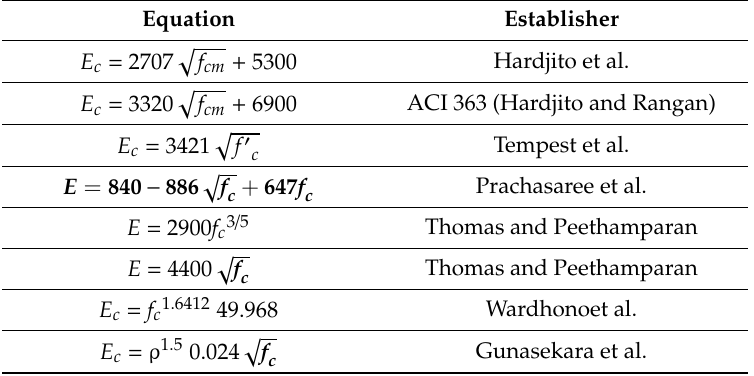
Table 6. Equations and